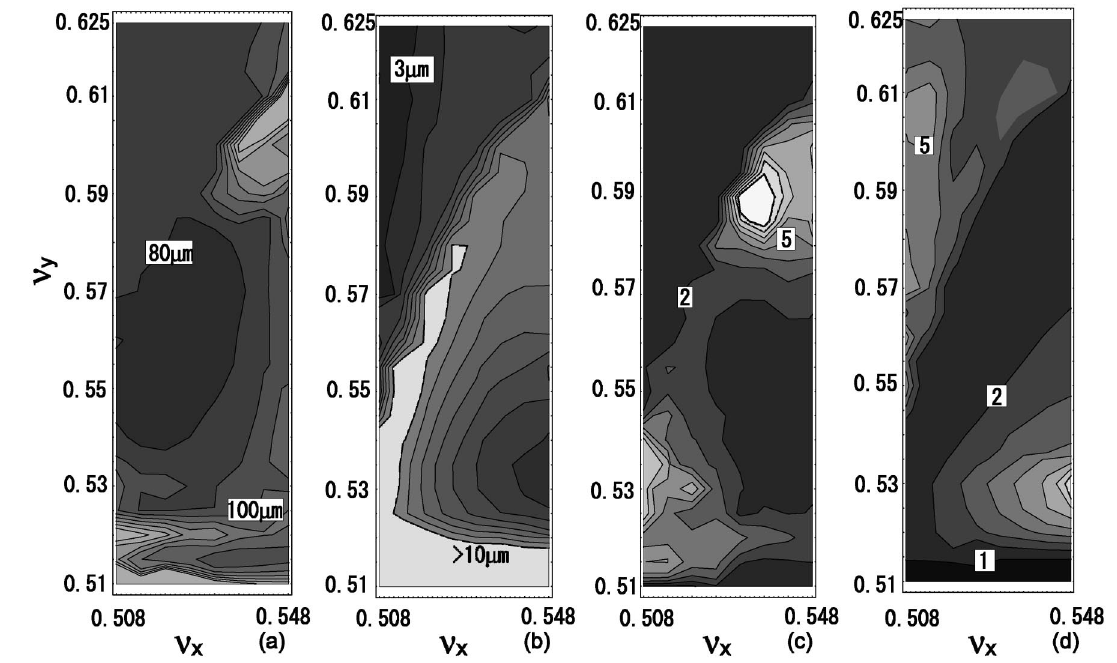
FIG. 7. Beam size and kurtosis in x - y tune space for zero-crossing angle. The horizontal and vertical beam sizes are depicted in (a) and (b), respectively. The horizontal and vertical kurtosis are depicted in (c) and (d), respectively. The contour lines are drawn every 10 + m , 1 + m , and 1 for horizontal, vertical beam size, and kurtosis, respectively, and lighter gray corresponds larger beam size and kurtosis.